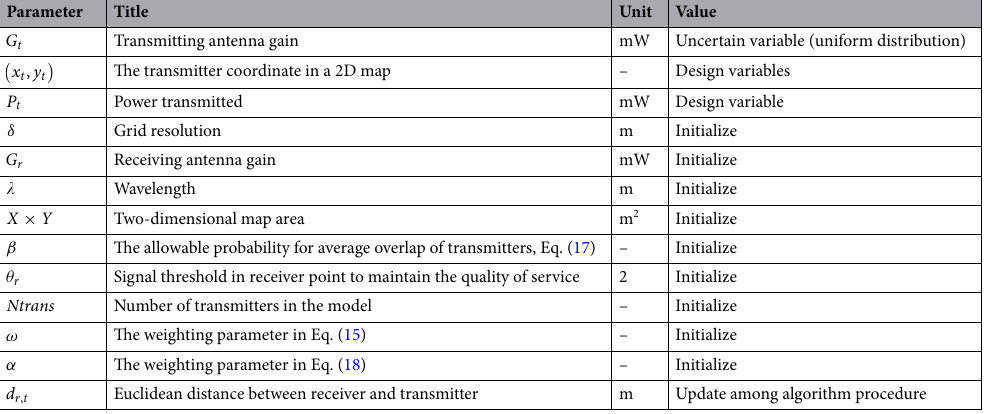
Table 1. The list of parameters applied in the proposed